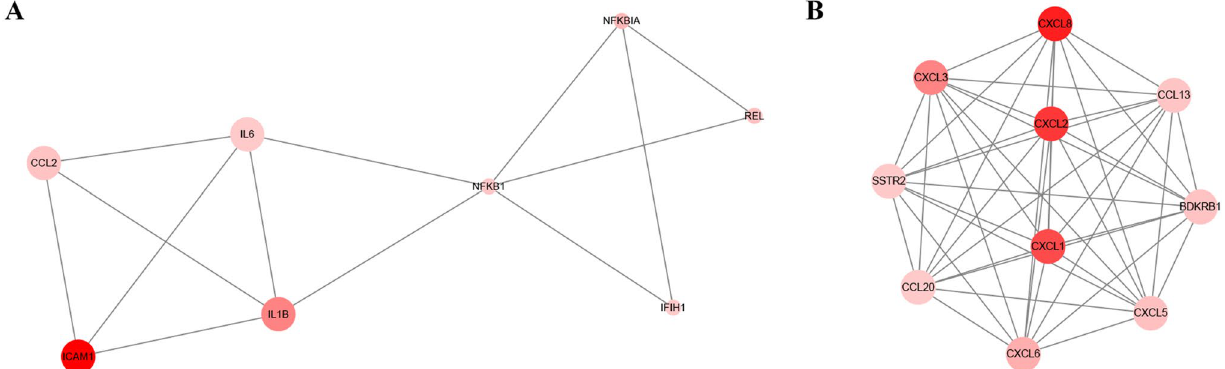
Figure 4. Protein–protein interaction network analysis using the STRING database. ( A , B ) Two core subnetworks of the network constructed by the top 30 K-score genes of Fig. S2. Different sizes represent K-score values. Different colors represent the absolute value of the fold change. Protein names were used to label the genes. Data was analyzed and created using Apps CentiScaPe 2.2 and MCODE in Cytoscape 3.8.0, Software.